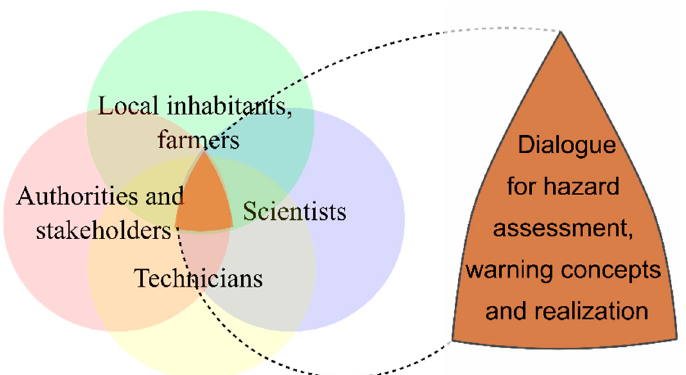
Figure 17. Necessary overlap for constructive and successful communication between the different entities of the hazard monitoring concept. entities of the hazard monitoring